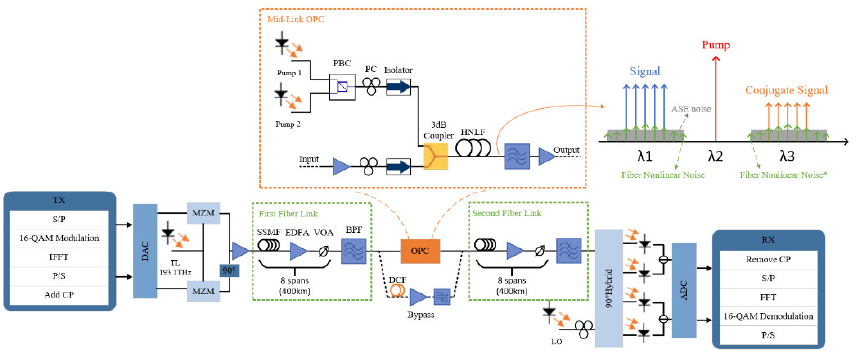
Figure 1. A diagram of 16-QAM coherent-optical orthogonal frequency-division multiplexing (CO-OFDM) transmission with mid-link optical phase conjunction (OPC) compensation.